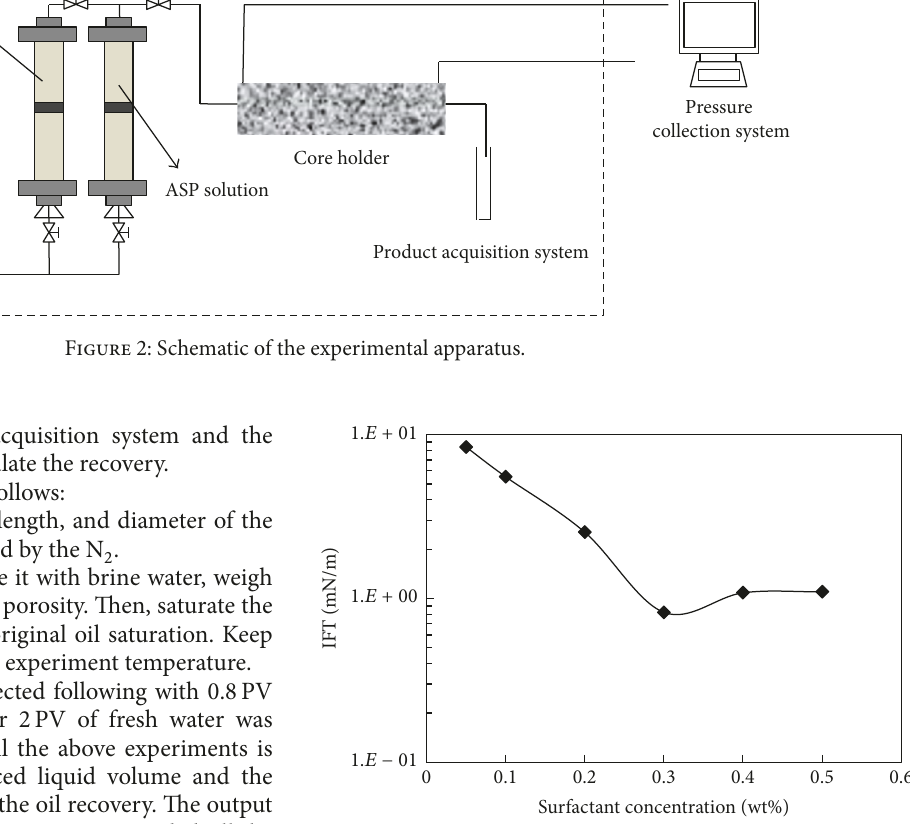
Figure 3: IFT between surfactant solution and oil with different surfactant